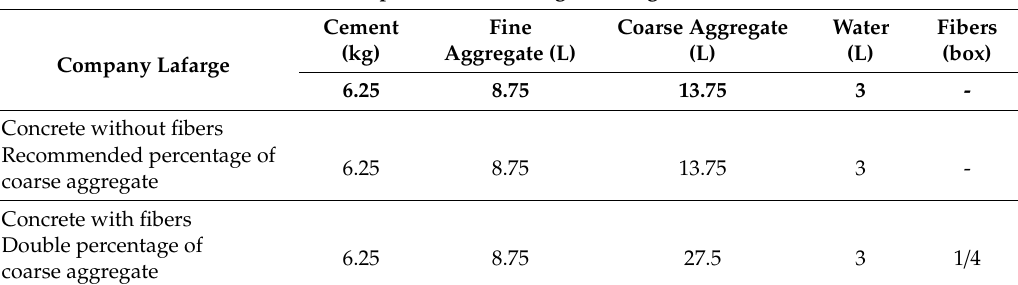
Table 6. Mixture proportions for C25 concrete.